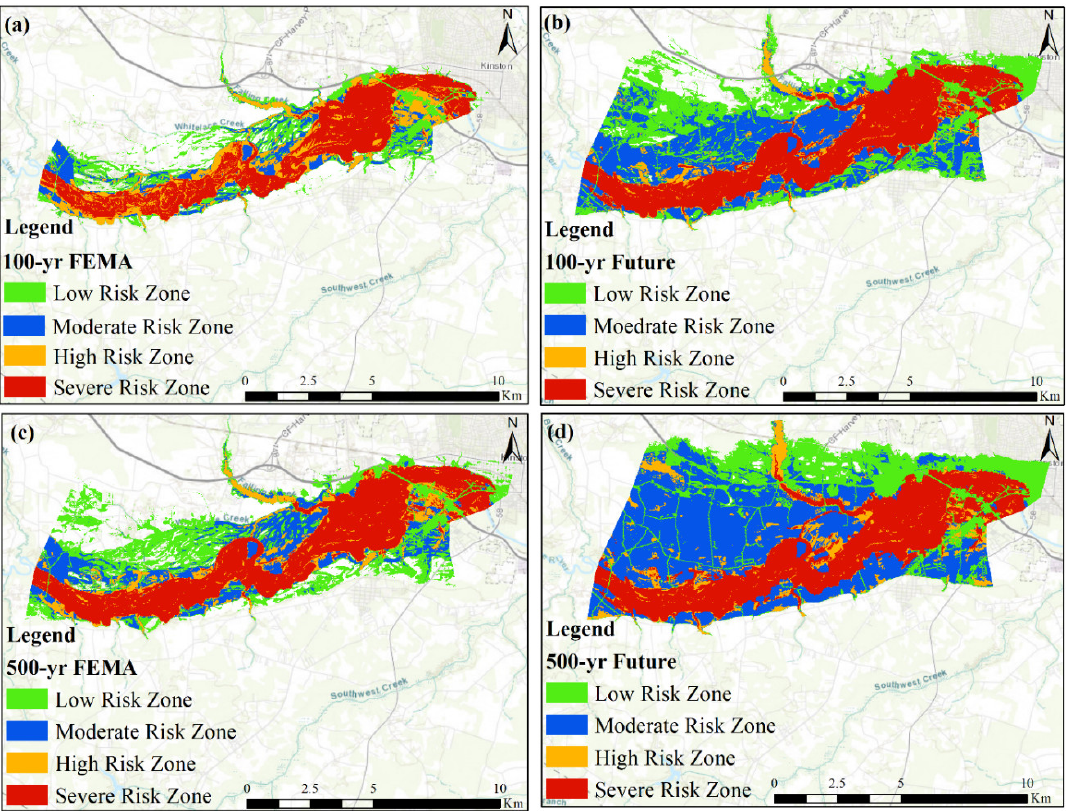
Figure 9. Floodplain mapping based on the risk zone analysis utilizing different flooding scenarios, i.e., FEMA and Future, respectively, for ( a , b ) 100-year and ( c , d ) 500-year return period flood events. Source: Esri, HERE, Garmin, Intermap, increment P Crop., GEBCO, USGS, FAO, NPS, NRCAN, GeoBase, IGN, Kadaster NL, Ordnance Survey, Esri Japan, METI, Esri China (Hong Kong), swisstopo